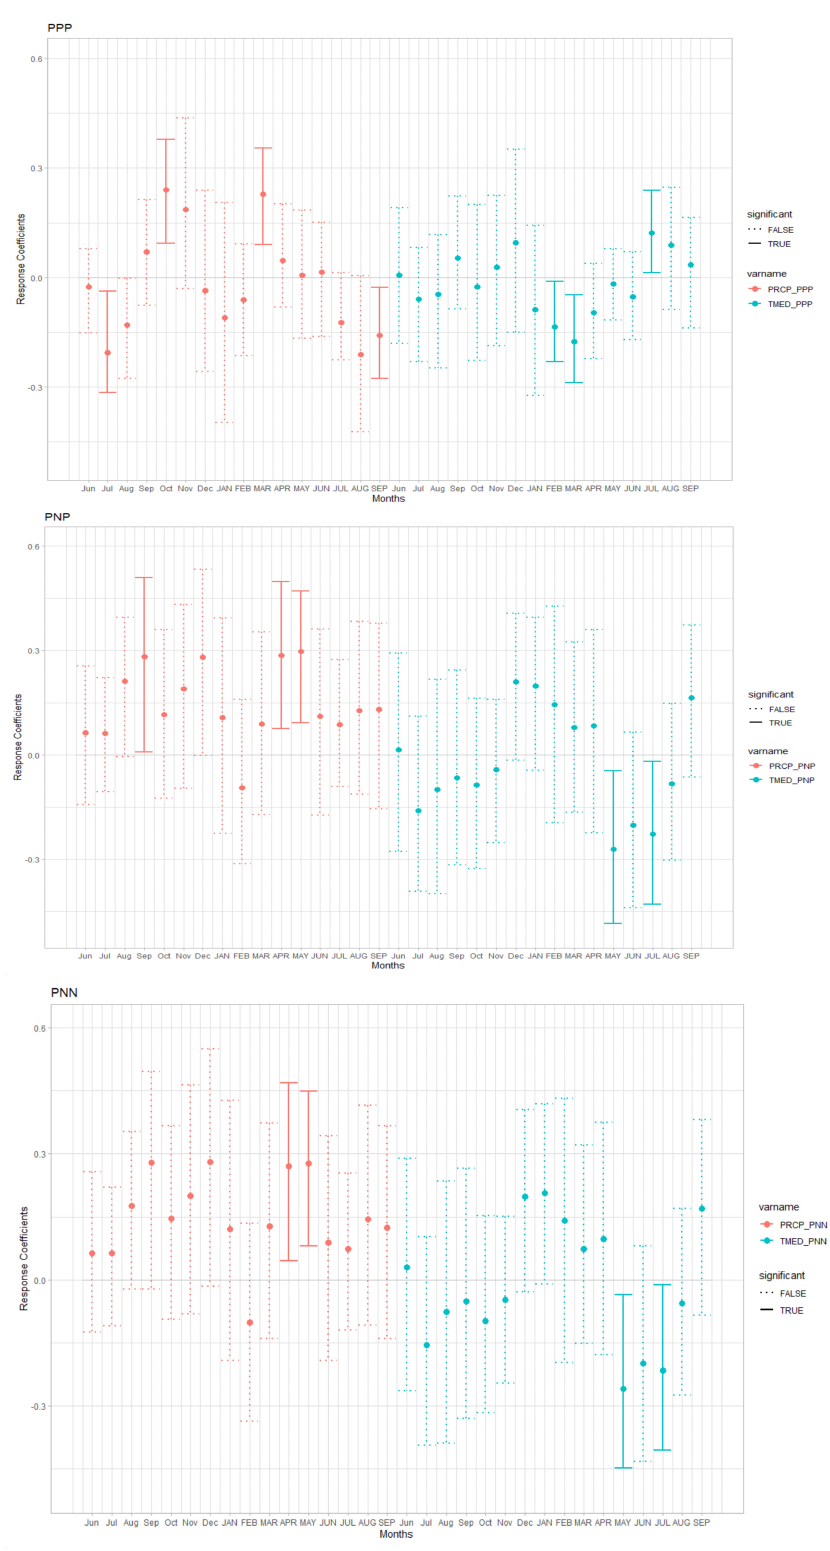
Figure 2. Bootstrapped response function analysis relating tree-ring growth to monthly mean temperature (blue bars) and precipitation (red bars) from previous June to current September in Pinus pinaster (PP) and P. nigra (PN) natural (PPN and PNN) and planted (PNP and PPP) stands. Previous- year months are given in lowercase letters, whereas current-year ones are shown in uppercase letters. Significant correlations ( p < 0.05) are presented with continuous